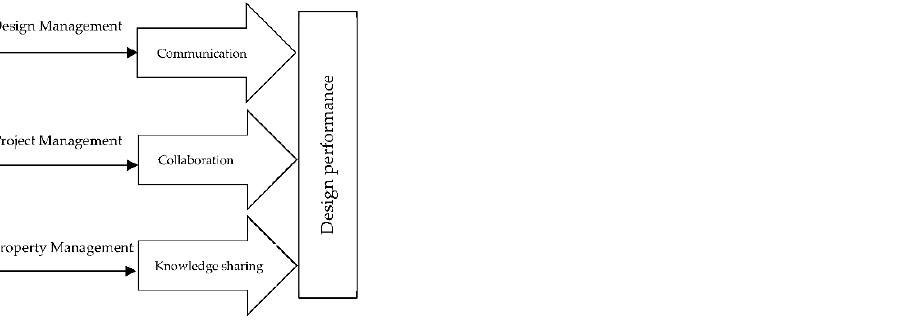
Figure 5. Negative relationship of factors to design performance according to each stakeholder.